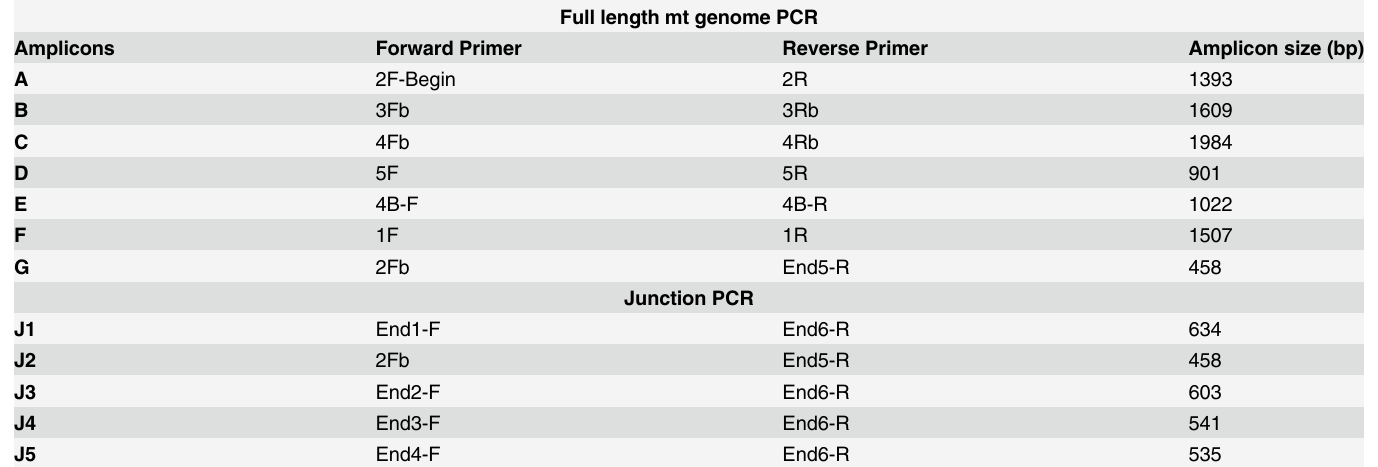
Table 2. PCR primer sets and amplicons.